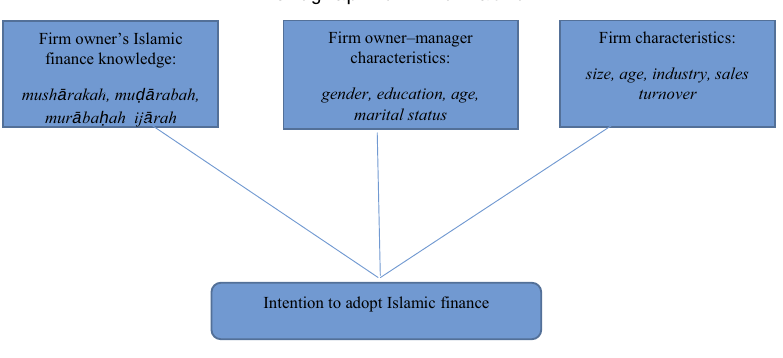
Figure 1. Relationship